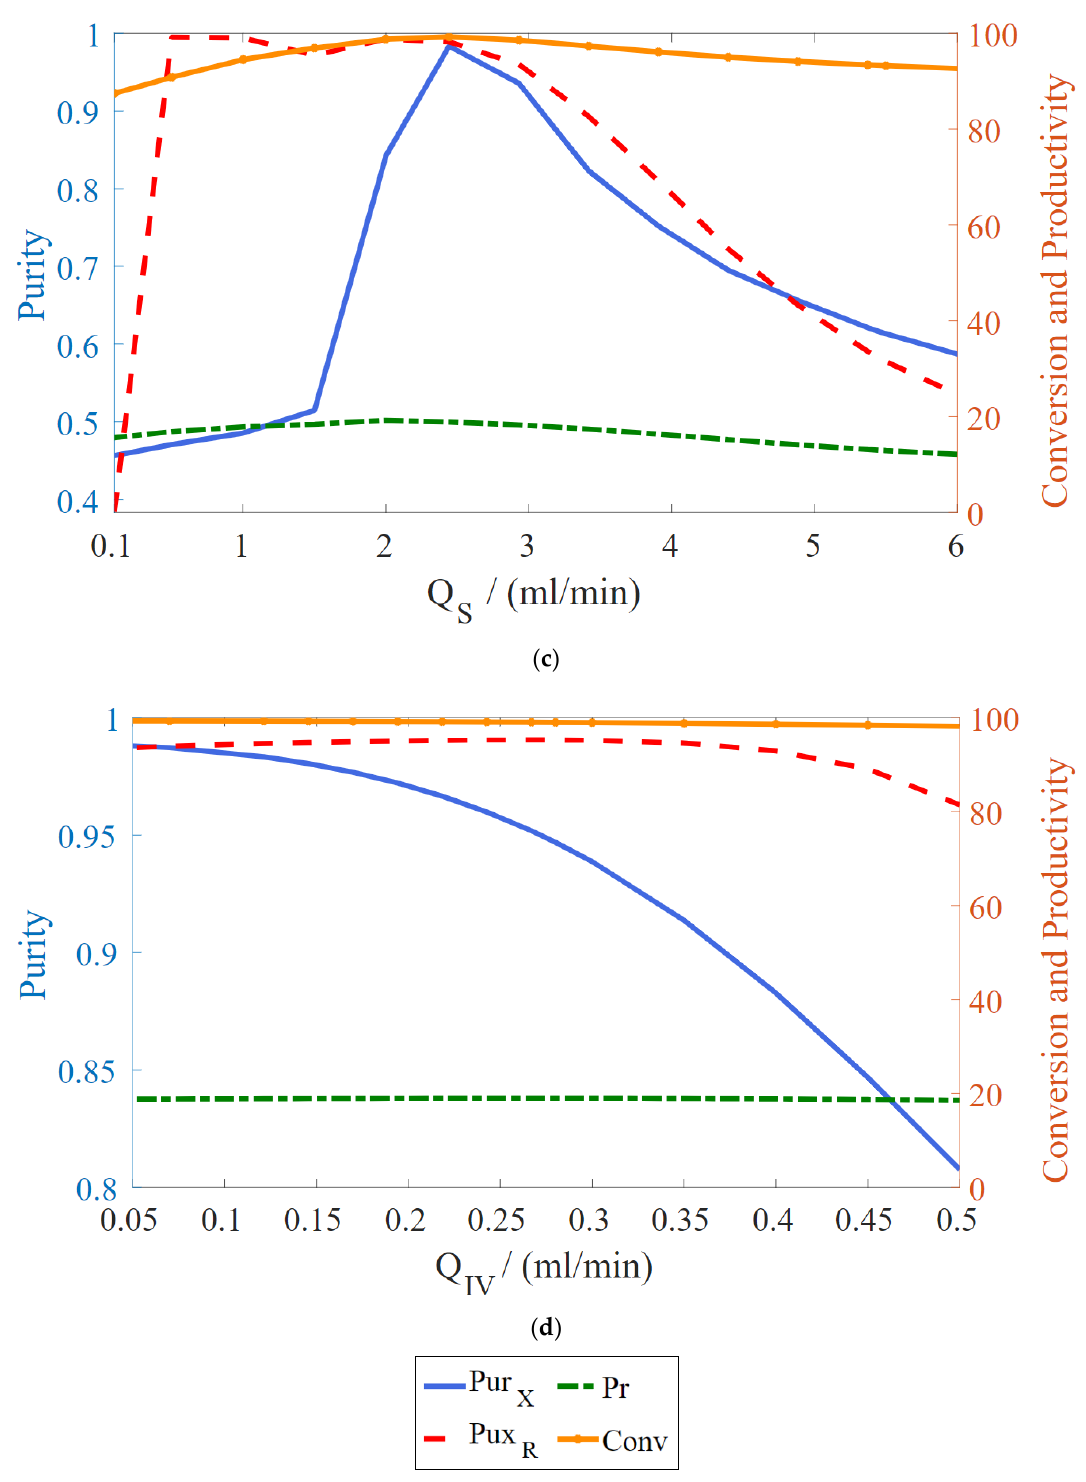
Figure 5. Performance parameter behaviors with variations of ( a ) feed ( 𝑄 𝐹 ), ( b ) extract ( 𝑄 𝑋 ), ( c ) solid ( 𝑄 𝑆 ), and ( d ) recycle ( 𝑄 𝐼𝑉 ) flow rates.